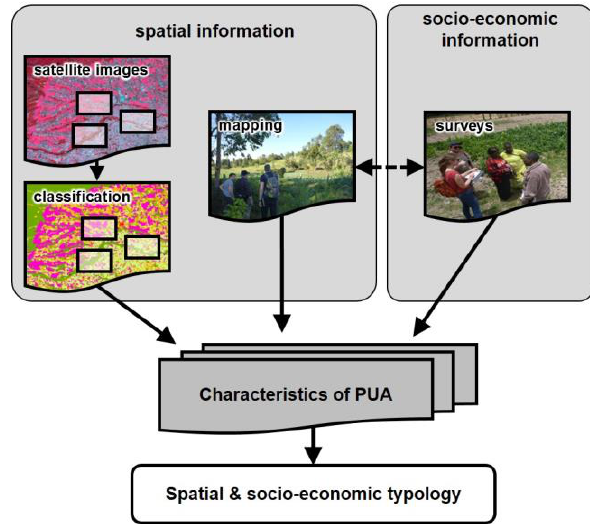
Figure 1: Methodical concept of the research